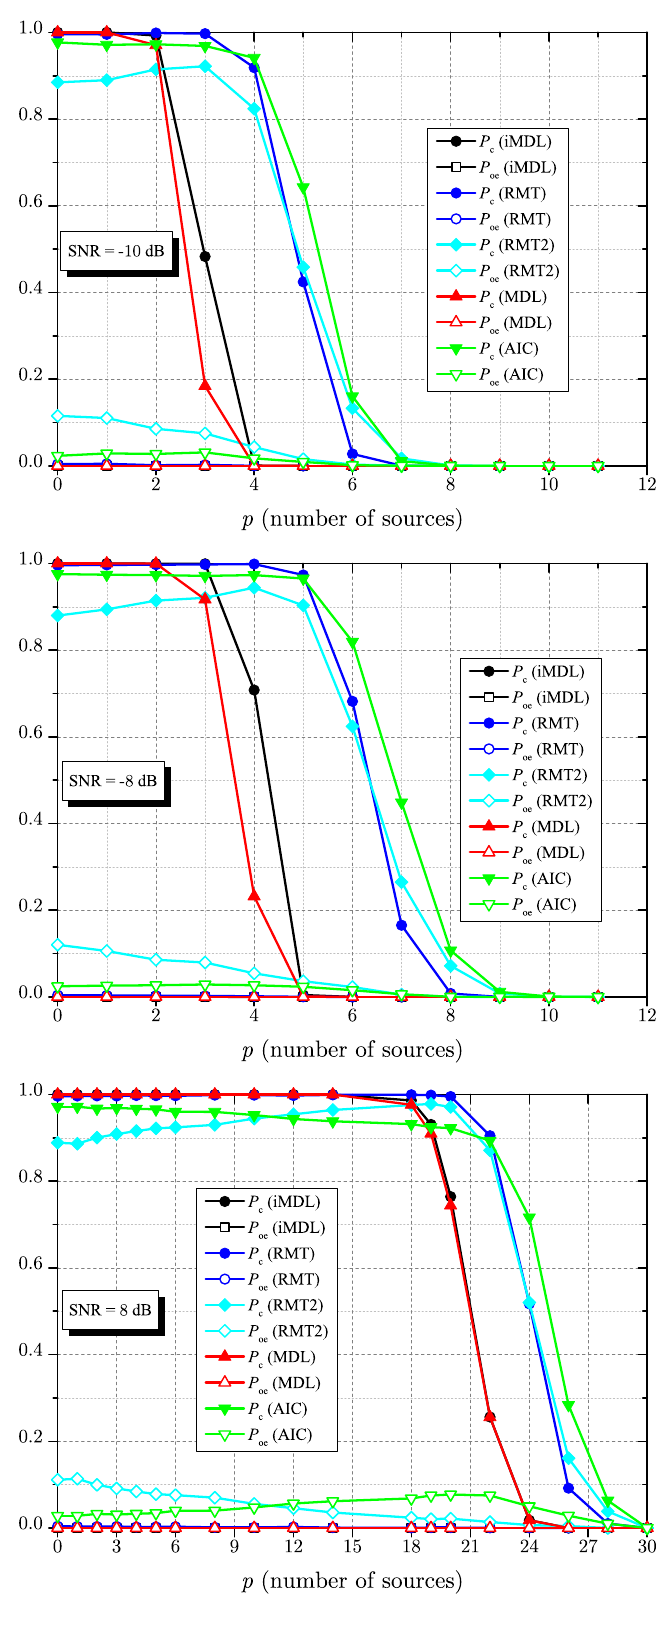
Figure 5. P and P against p for m = 30 , n = 1000 , SNR = − 10 dB ( top ); SNR = − 8 dB c oe ( middle ) and SNR = 8 dB ( bottom